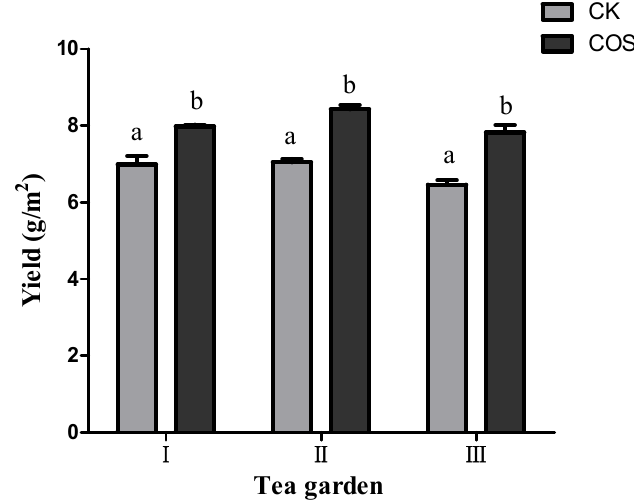
Figure 3. Effect of application of COS on tea yields. The data represent the means ± SD of three replicates samples. Different letters indicate s-ignificant differences at p < 0.05. I, II and III represent three teagardens in Meitan County, Ziyun County, and Pingtang county, respectively.